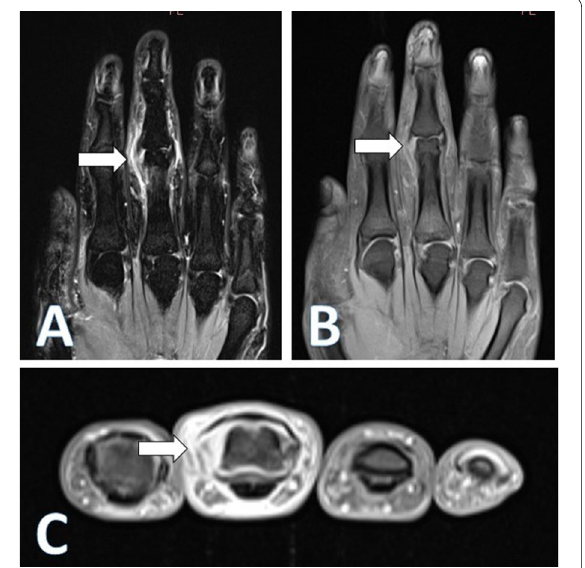
Fig. 3 Male patient 43 years old, complaining of post-traumatic pain at the lateral aspect of the middle finger at the level of the PIP. Coronal T2 STIR ( a ), coronal T1WI fat-saturated ( b ), and axial T2WI fat-saturated ( c ) imaging of the right middle finger showing discontinuity of the proximal fibers of the lateral collateral ligament of the middle finger at the level of the PIP (white arrow) with related fluid signal intensity. Diagnosis was complete tear of the radial collateral ligament of the right middle finger at the level of the PIP